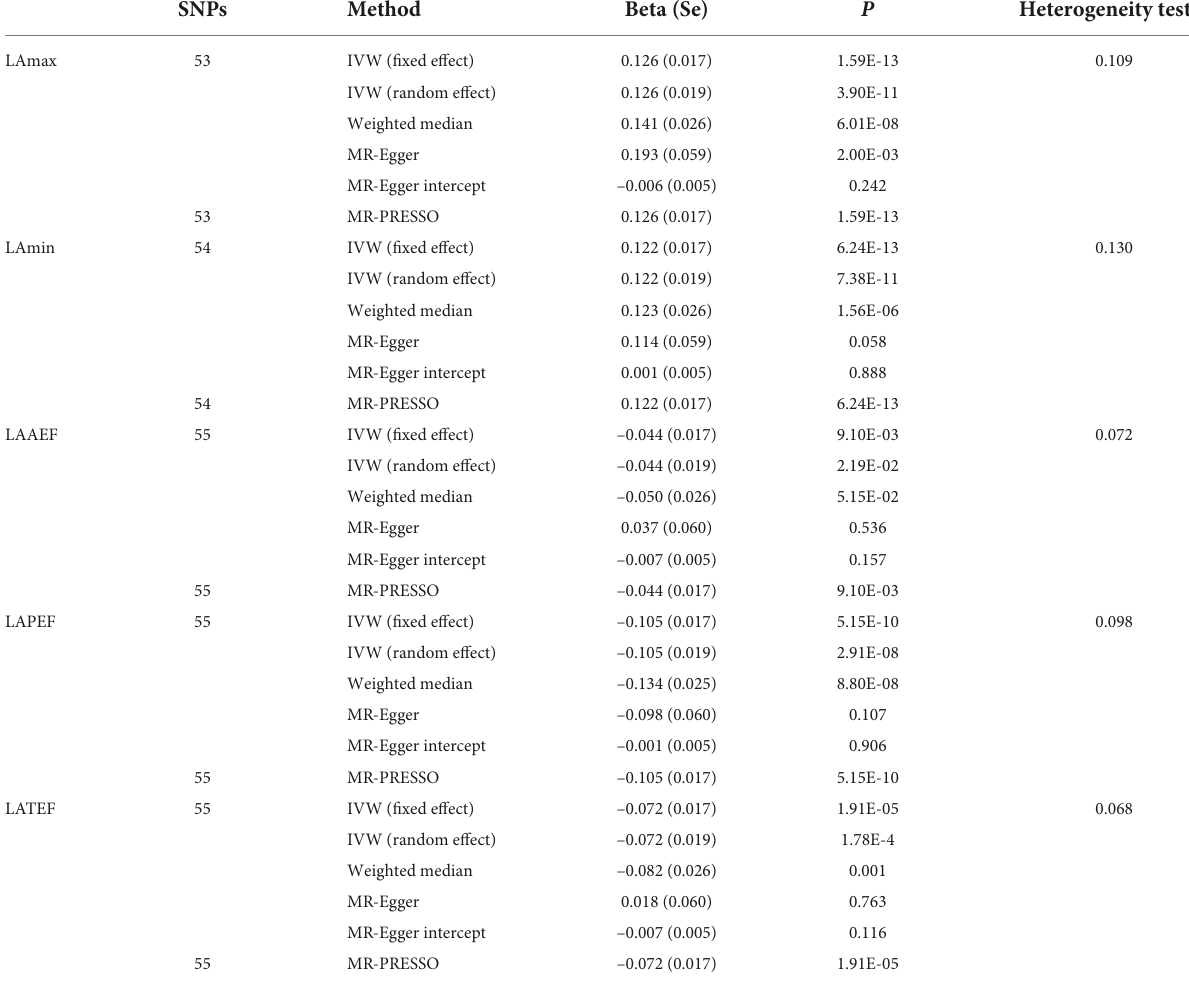
TABLE 1 Estimated effect size of hypertension and LA with different MR